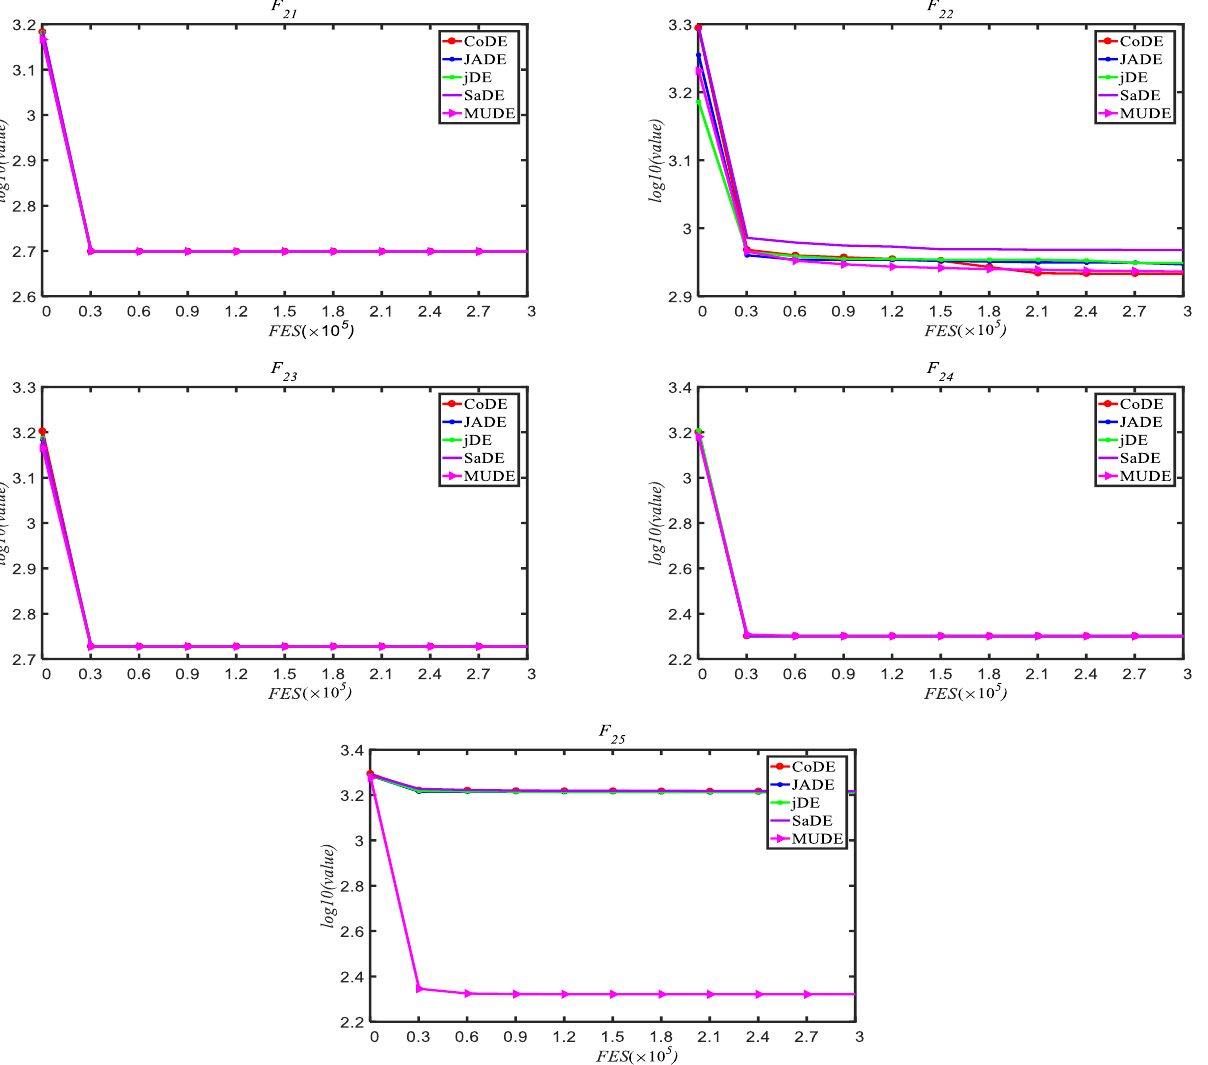
Figure 4. The variation process of the average optimum solutions for F 1~ F 25 with dimension D = 30 over 25 runs.